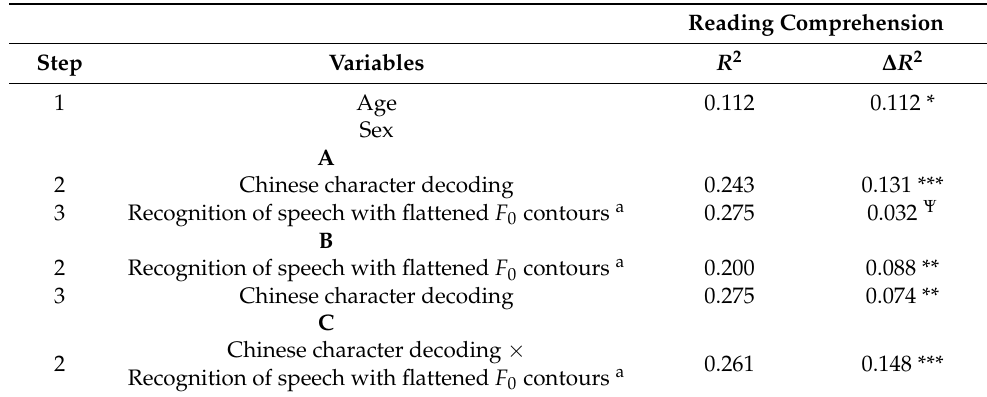
Table 4. Hierarchical regression analyses predicting reading comprehension from Chinese character decoding and recognition of speech with flattened F 0